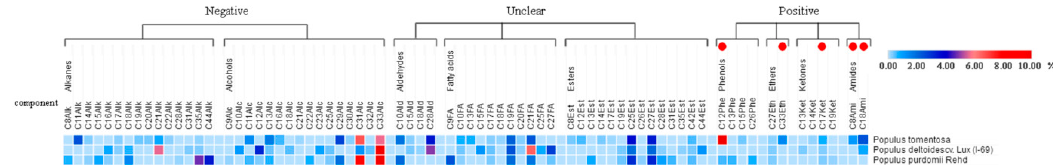
Figure 4. Relative concentrations of all cuticle compounds of the three poplar taxa varying in resistance to M. larici - populina . Note: Higher concentrations are in darker blue and then red. The red dots were the compounds selected for further assays and fully explained in Table 3.